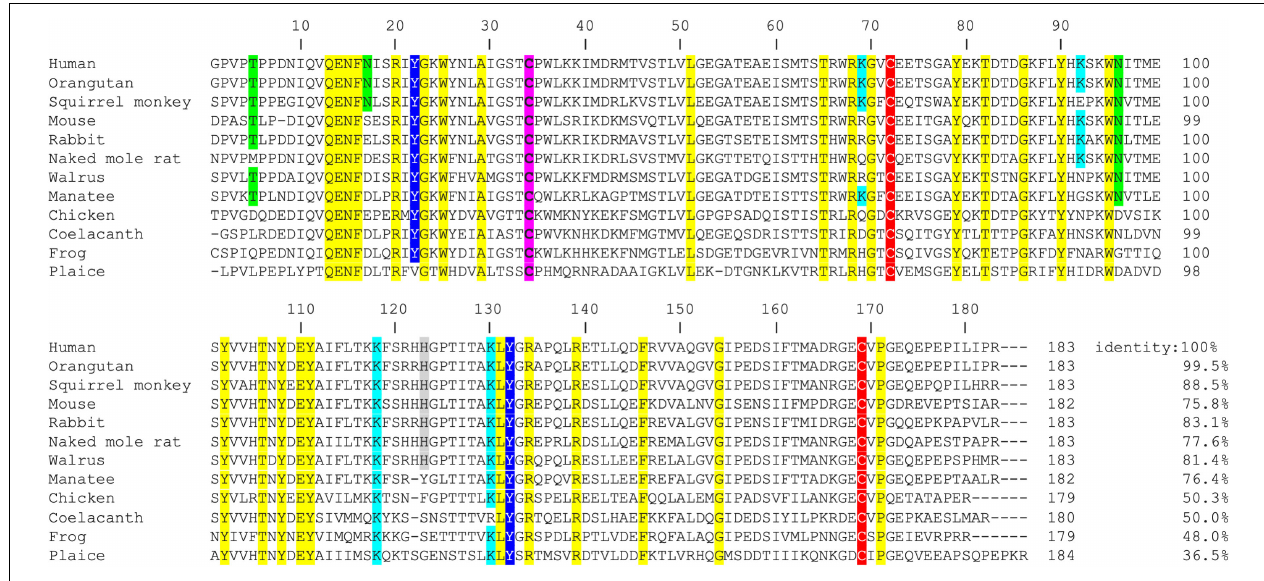
FIGURE 2 | Amino acid sequence alignment of A1M from 12 different species. The amino acid sequence of human wild-type (wt) A1M and 11 additional species were retrieved from public data bases (www.ncbi.nlm.nih.gov and www.uniprot.org) and aligned using the http://www.ebi.ac.uk/Tools/msa/clustalw2/ software. The degree of identity of the different sequences to the human sequence is presented as percent relative to human A1M. Amino acids with reported functional impact in human A1M are marked: the C34, described to be important for reduction and antioxidant properties as well as heme binding, is marked with pink. Glycosylated positions (T5, N17, and N96) are marked with green. Lysine residues (K69, K92, K118, and K130), described to be related to the yellow-brown modifications, are marked with light blue. The disulfide bridge, formed between C72 and C169, is marked in red. H123, suggested to take part in coordination of heme-iron, is marked with gray. Tyrosines (Y22 and Y132), shown to be modified in radical scavenging reactions are marked in dark blue. Of these functionally important amino acids, five are completely conserved in all 12 species (C34, C72, K118, Y132, and C169). Additional 28 amino acids, which are identical between all species in the set, are marked with yellow. Human, Homo sapiens ; Orangutan, Pongo abelii ; Squirrel monkey, Saimiri boliviensis boliviensis ; Mouse, Mus musculus ; Rabbit, Oryctolagus cuniculus ; Naked mole rat, Heterocephalus glaber ; Walrus, Odobenus rosmarus divergens ; Manatee, Trichechus manatus latirostris ; Chicken, Gallus gallus ; Coelacanth, Latimeria chalumnae ; Frog, Xenopus laevis ; and Plaice, Pleuronectes platessa .